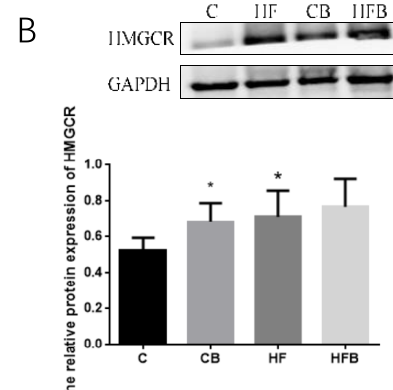
Figure 5. Effects of betaine and high-fat diet on concentration of CPT1 in the liver of rats ( n = 8): the concentration of hepatic Carnitine palmitoyl transferase1 (CPT1, BET, p = 0.002, FAT, p = 0.148, interaction, p = 0.361). # Significantly different from the HF group ( p < 0.05).